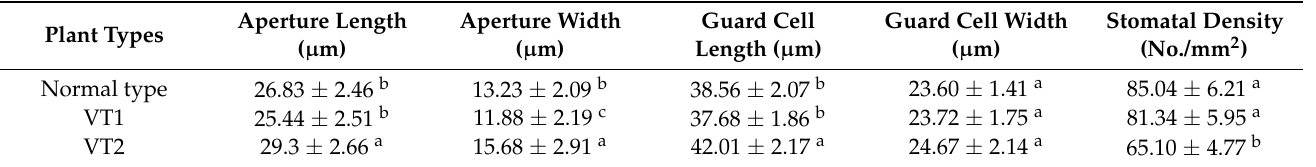
Table 5. Differences in stomatal parameters among the normal-type ginger and the two variation types at harvest.